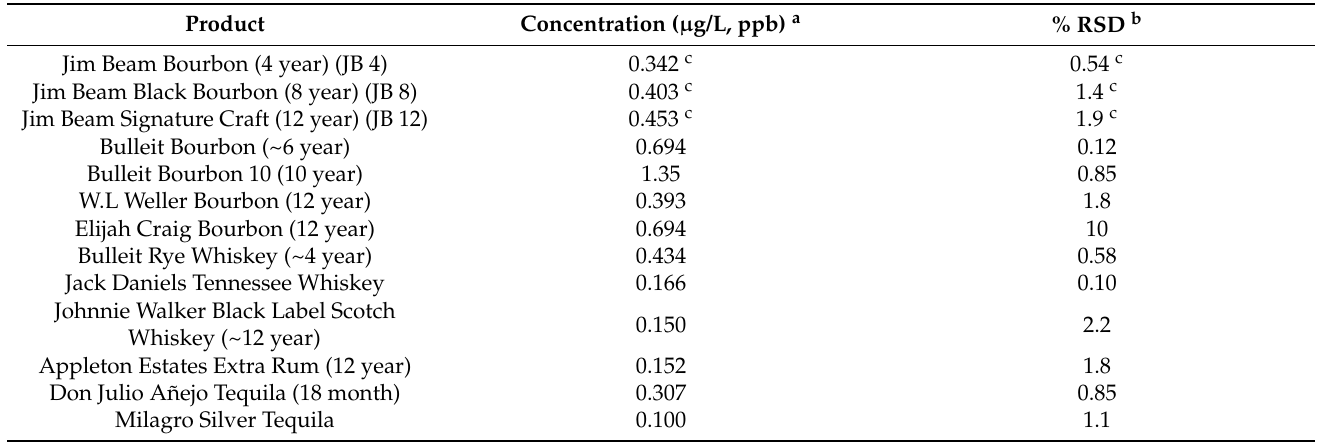
Table 2. Concentration of rotundone in oak-aged distilled